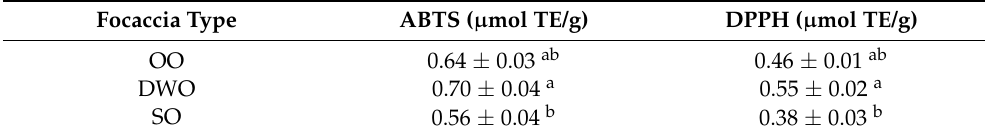
Table 4. Total antioxidant capacity of experimental focaccia . OO = focaccia prepared with olive oil; DWO = focaccia prepared with durum wheat oil; SO = focaccia prepared with sunflower